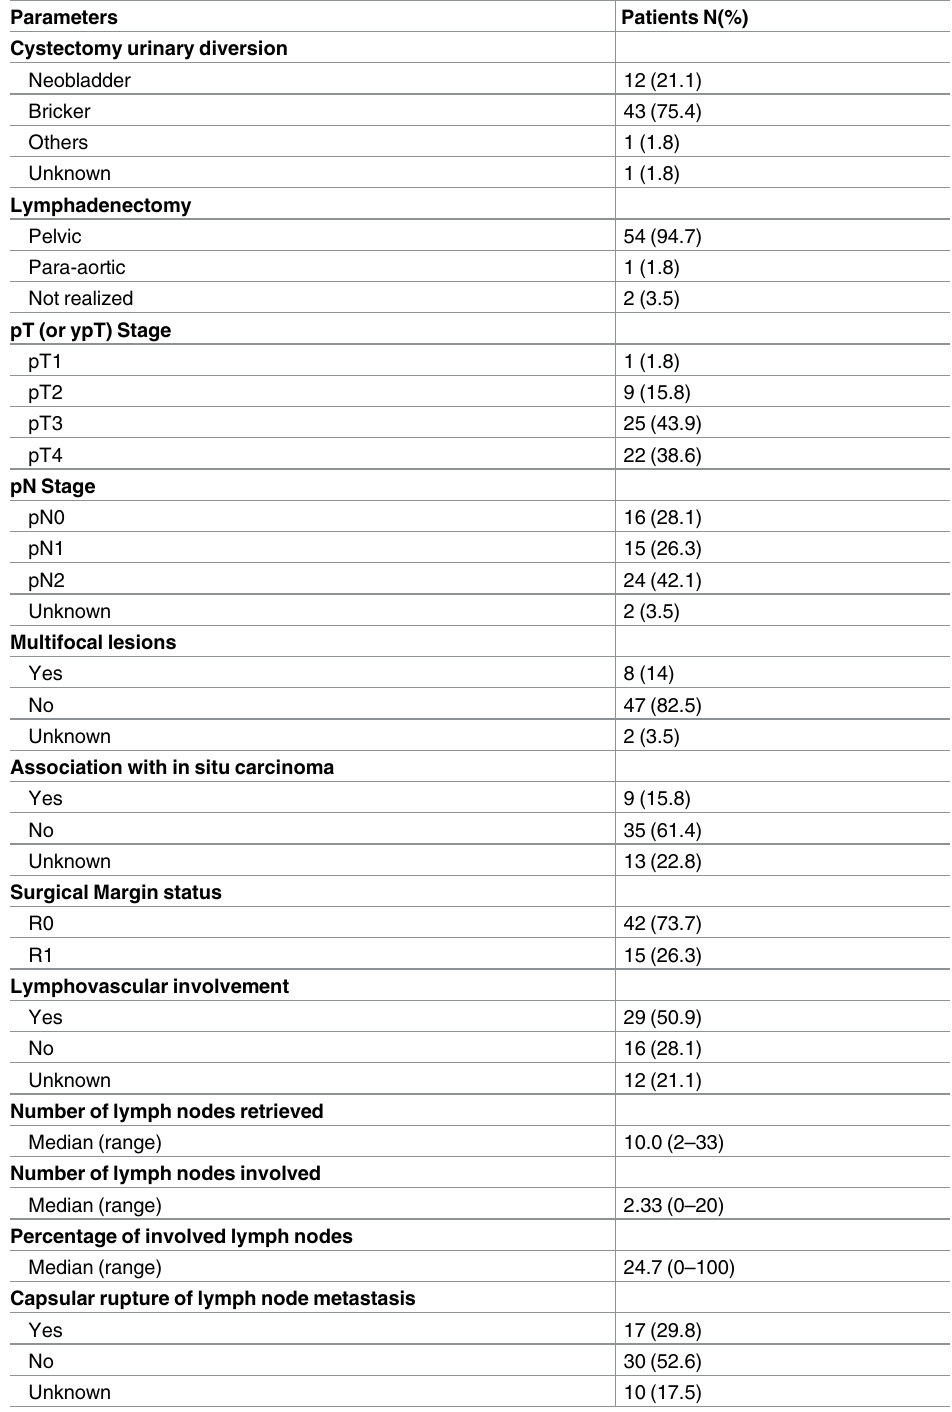
Table 2. Pathological characteristics at radical